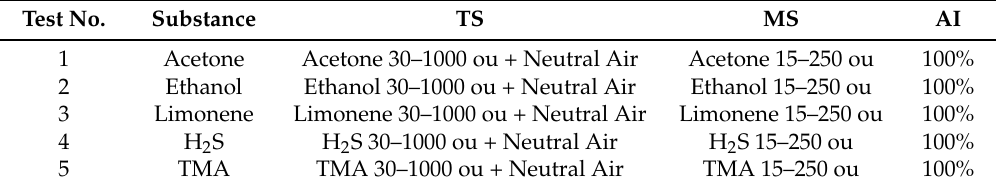
Table 6. Scheme and results of the tests for the evaluation of the instrumental detection limit towards the five target compounds.